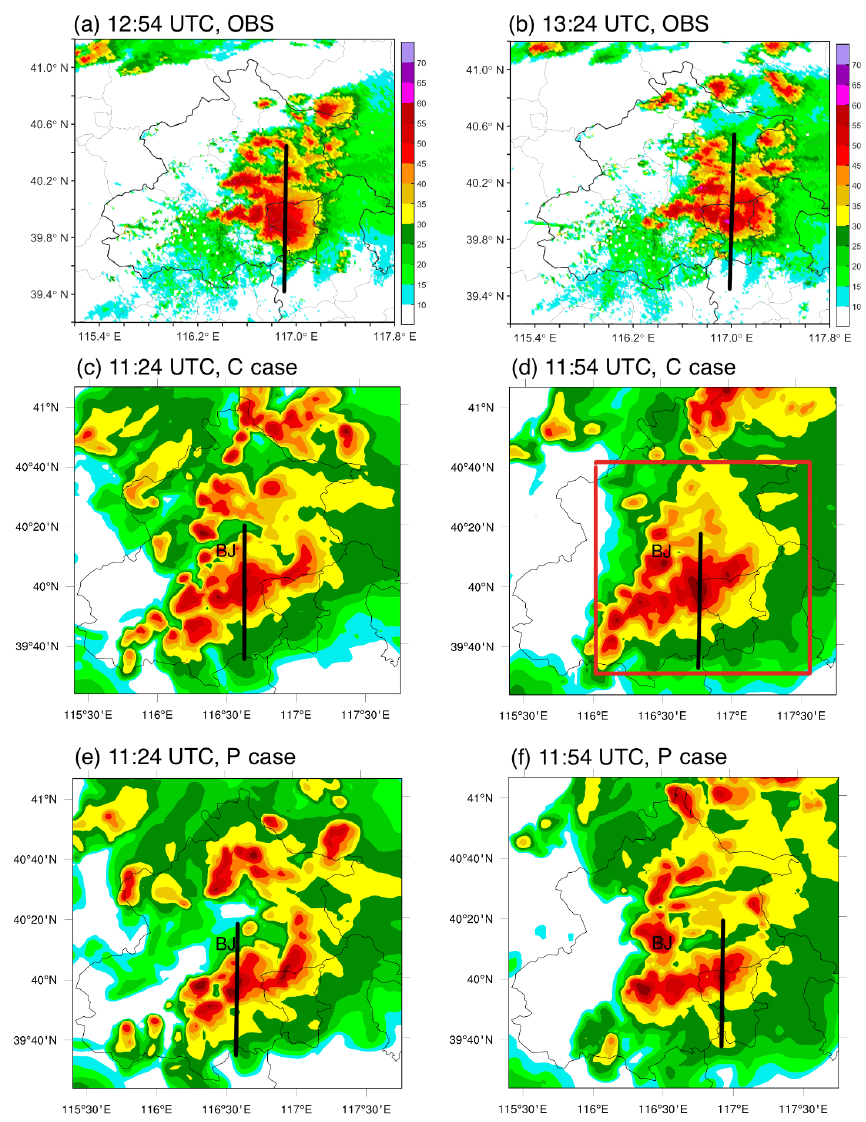
Figure 4. Radar reflectivity (unit dBZ) between observation and simulation for the C and P cases; the simulation was earlier than the observation by about 1.5h. (a–b) Observation at 12:54 and 13:24UTC. (c–d) Simulation for the C case at 11:24 and 11:54UTC. (e– f) Simulation for the P case at 11:24 and 11:54UTC. The red rectangle in (d) denotes the region where the simulated results are analyzed in this study. BJ is